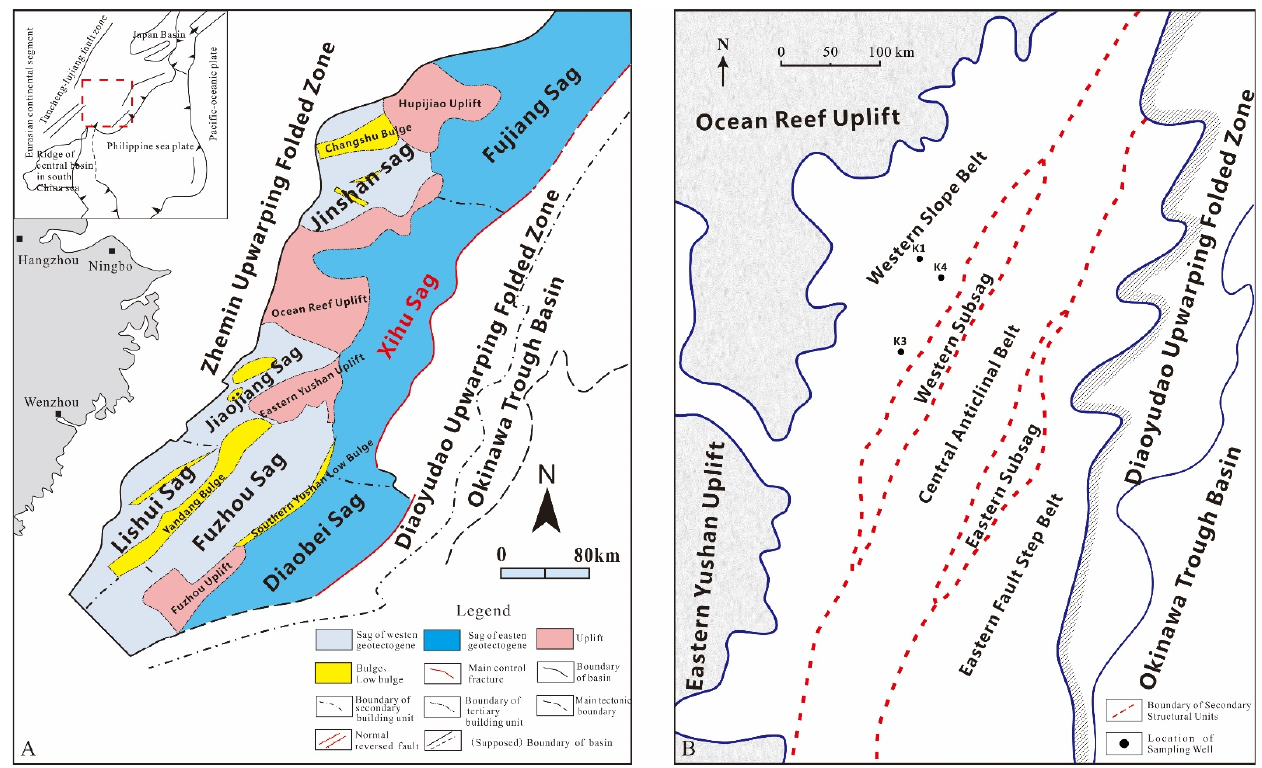
Figure 1. Sketch map showing the geographical position of tectonic units and oil and gas fields in the Xihu Sag, East China Sea Shelf basin (( A ) is for the overall effect and ( B ) is for a partial enlarged version).